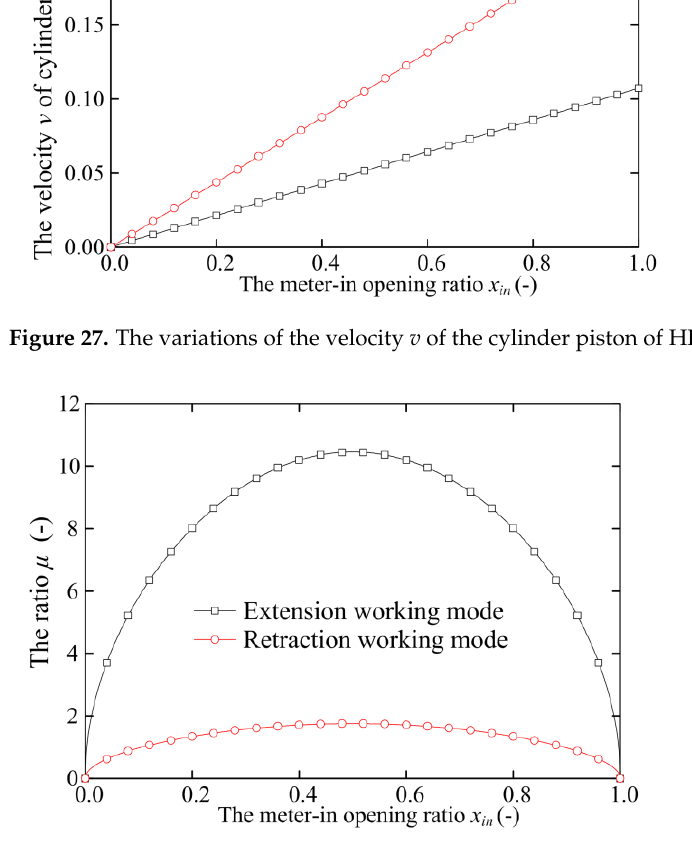
Figure 28. The variations of the ratio μ of HPCIMS.